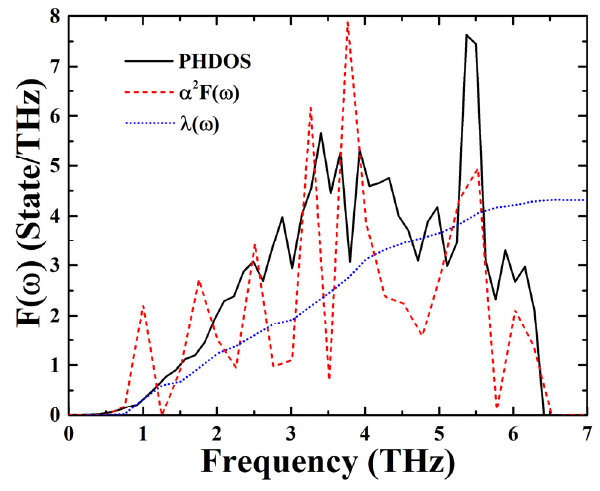
Figure 5. The electron–phonon coupling calculations of I 4/ mmm BaI 2 at 30 GPa.